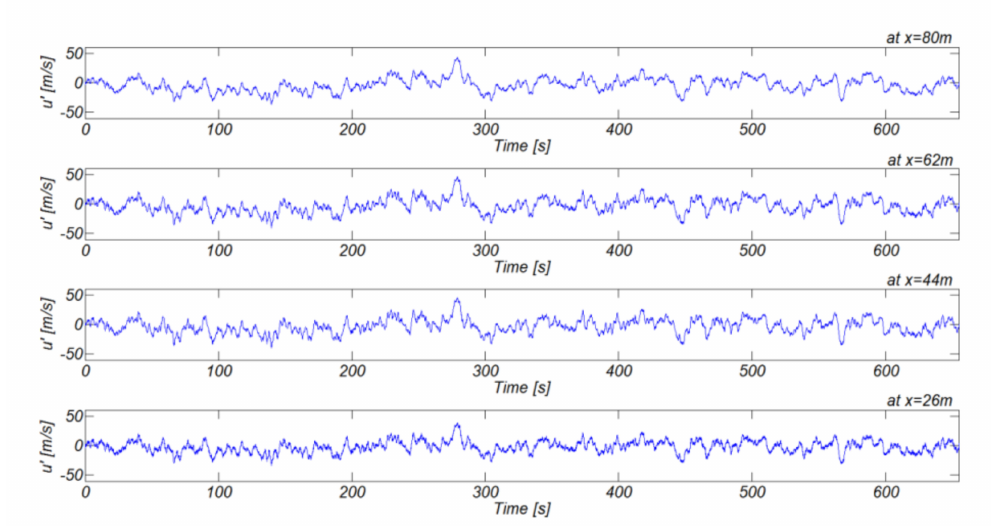
Figure 12. Time series for numerically simulated turbulent wind velocities at x = 80, 62, 44, and 26 m [calm sea].